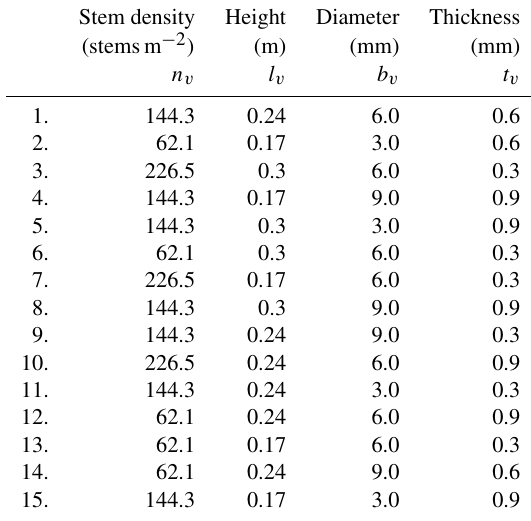
Table 2. Plant property input combinations for different simulations during sensitivity